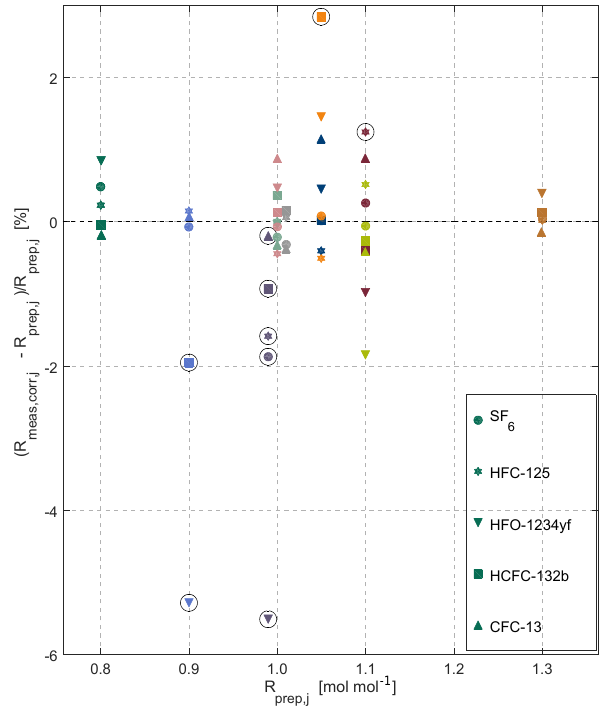
Figure 5. Overview of internal consistency estimates for the METAS-2017 calibration scales. Prepared and measured ratios of molar fractions for each substance (shown by different marker types) in each cylinder (shown using different colours, see colour legend in Fig. 4). Outliers are highlighted by black open circles (see main text Sect.